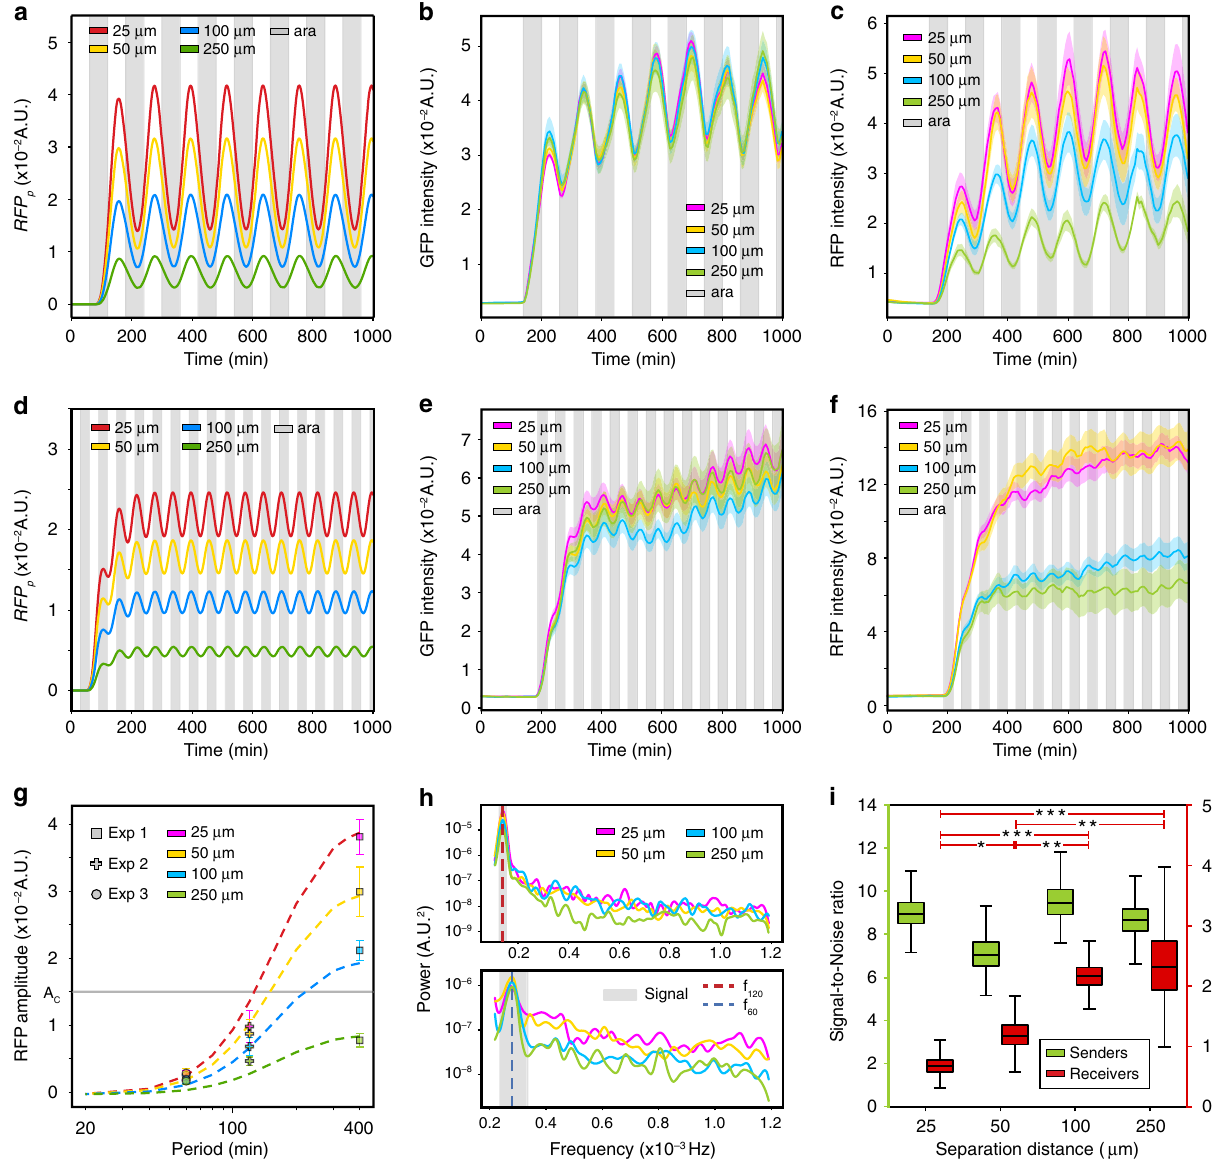
Fig. 3 The frequency of a periodic input determines the effect of distance on information transmission. a Model simulations of RFP p in response to a periodic arabinose input (2 h period). Gray shaded regions denote the presence of arabinose. b GFP as a function of time in response to an oscillatory arabinose input (2 h period). Gray shaded regions denote the presence of 0.1% arabinose. Colored shaded regions represent 1 SD from the mean. c RFP as a function of time in response to a periodic arabinose input (2 h period). d Model simulations of RFP p in response to a periodic arabinose input (1 h period). e GFP over time in response to an oscillatory arabinose input (1 h period). f RFP in response to an oscillating arabinose input (1 h period). g RFP amplitude as a function of the input period at different distances. Square, plus, and circular data points represent the amplitudes in the step response, 2 h and 1 h forced oscillator experiments, respectively. Error bars represent 1 SD from the mean amplitude. h Top: mean RFP power spectra in response to an input period of 2 h (red dashed line) for 395 – 1536 min. The gray shaded region denotes a bandwidth of ±10 min around the expected input frequency. Bottom: mean RFP power spectrum in response to an input period of 1 h (blue dashed line) for 500 – 1249 min. i Signal-to-noise (SNR) ratios computed using bootstrapped power spectra for GFP or RFP for each distance (Methods) in the 1 h forced oscillator experiment. The horizontal lines within boxes denote the median and upper and lower edges represent the upper and lower quartiles, respectively. Upper and lower whiskers represent the 95th and 5th con fi dence intervals, respectively. Horizontal lines with stars denote statistically signi fi cant differences ( P < 0.05) based on a one-tailed bootstrapped hypothesis test (Methods). * P < 0.05, ** P < 0.01, and *** P < 0.001 (Supplementary Fig. 16). Source data are provided as a Source Data fi